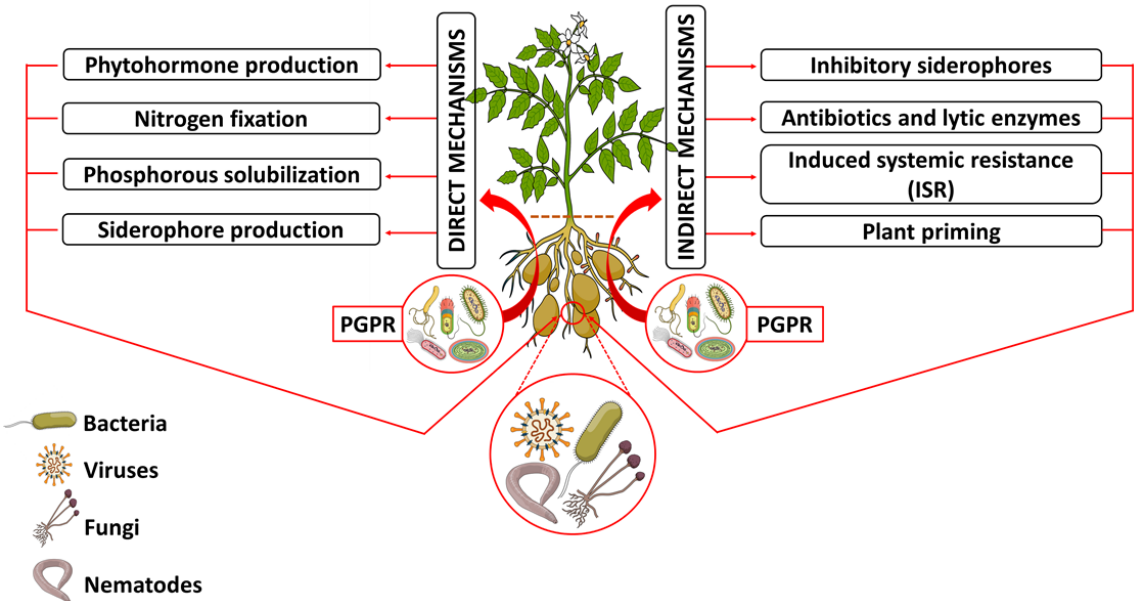
Figure 3. Schematic representation of the direct and indirect mechanisms of action employed by PGPR in plant growth promotion and protection. PGPR mechanisms contribute directly to plant growth by nitrogen fixation, solubilising nutrients such as phosphorous and the production and secretion of beneficial metabolites, including phytohormones and siderophores. At the same time, indirect interactions result in the protection of the plant from biotic and abiotic stress through ISR, antibiosis and plant priming.